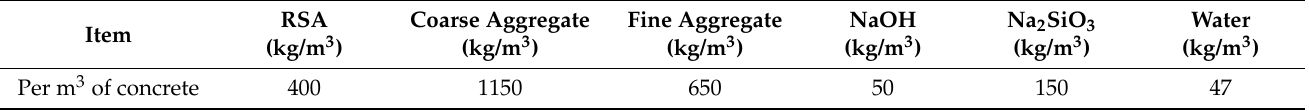
Table 4. Mix design of